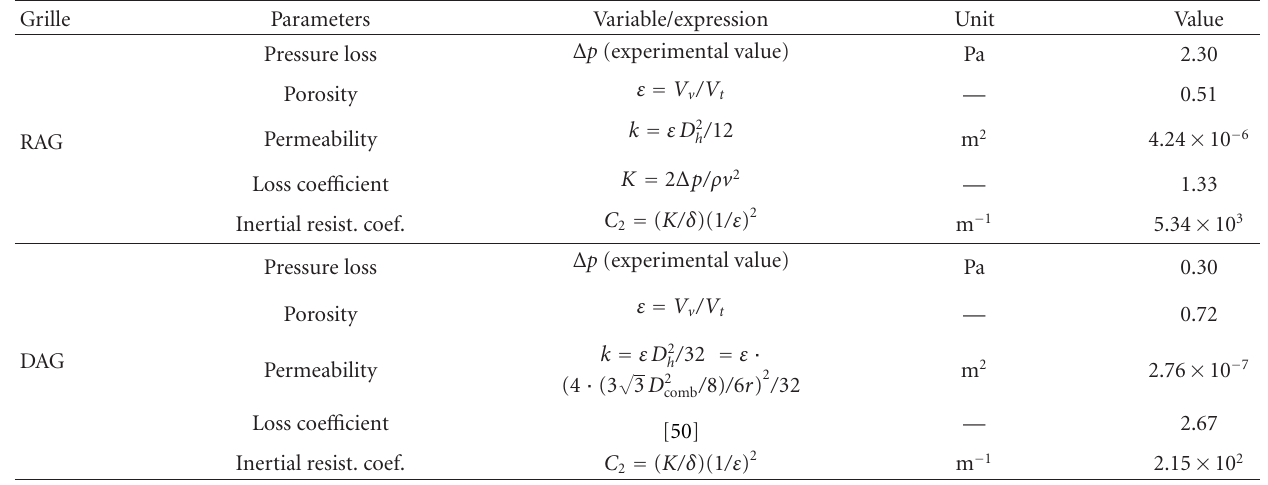
Table 7: DAG and RAG porous medium parameters.